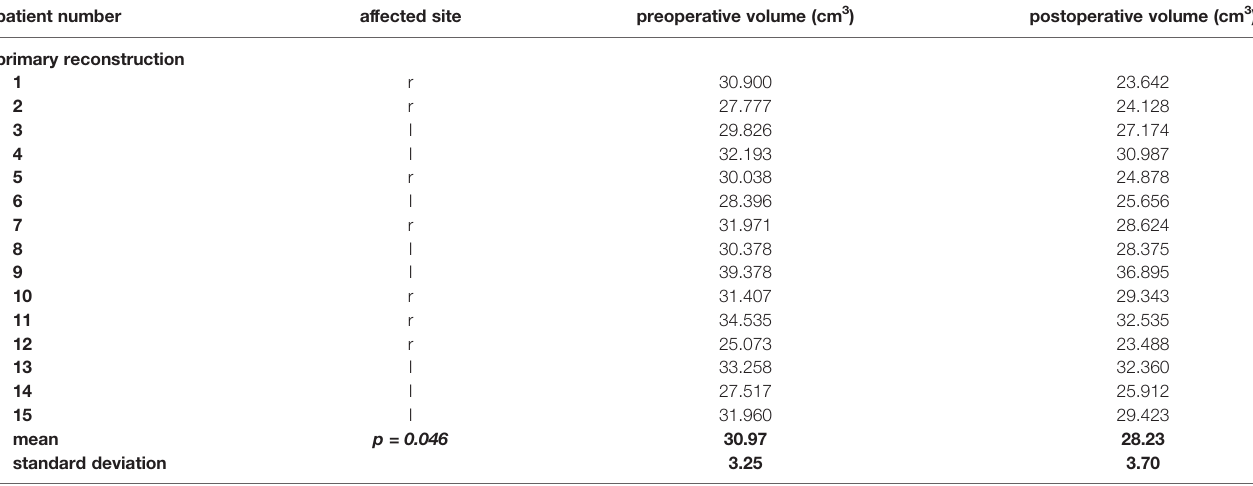
TABLE 3 | Pre- and postoperative volumes of the patients with a primary reconstruction of the orbit using the CAS. patient number